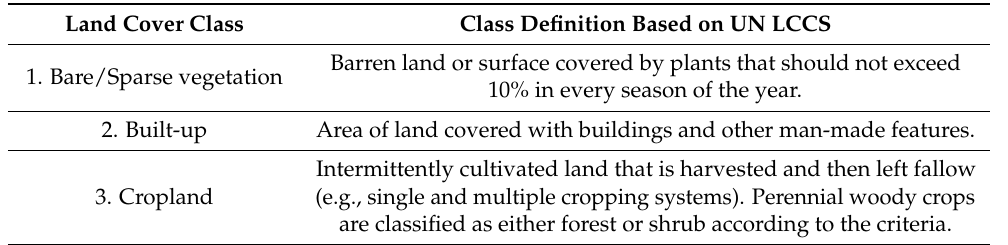
Table 1. Land cover classes and their definition, modified after Smets, et al.